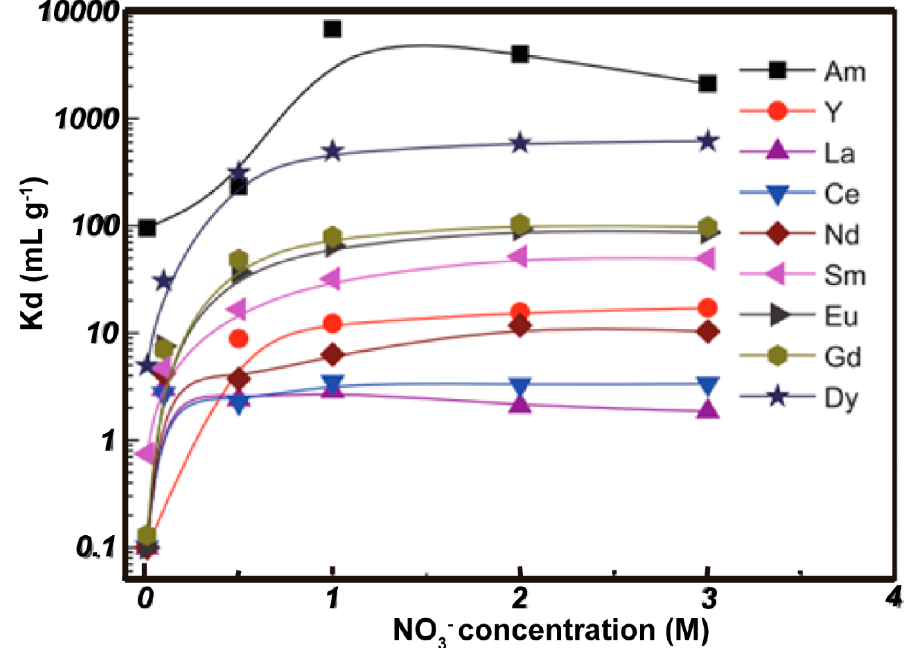
Figure 10. Structure formula of Me 2 -CA-BTP (5,6,7,8-tetrahydro-5,8,9,9-tetramethyl-5,8-methano-